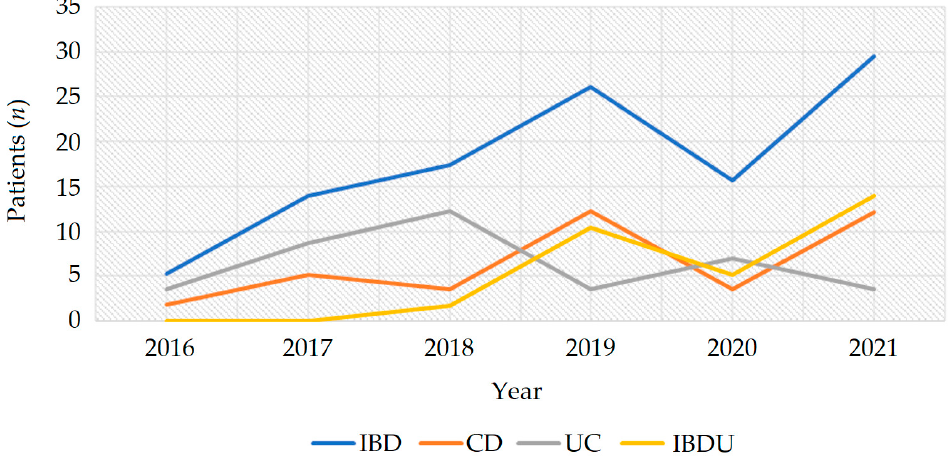
Figure 2. IBD incidence in the Healthcare District of Bra in the time span 2016–2021. Abbreviations: CD, Crohn’s disease; IBD, inflammatory bowel disease; IBDU, IBD unclassified; UC, ulcerative co- litis.